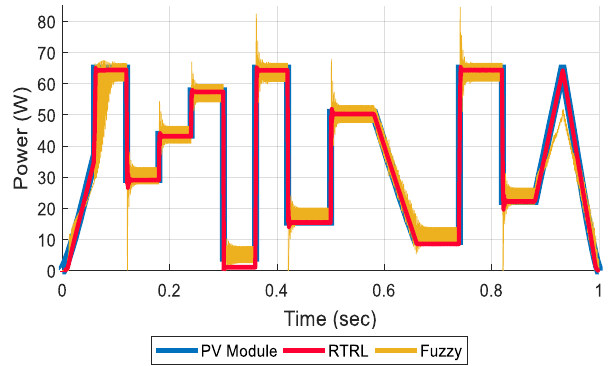
Figure 20. Results obtained with the RTRL and Fuzzy controllers for a signal of variable irradiance and constant temperature.